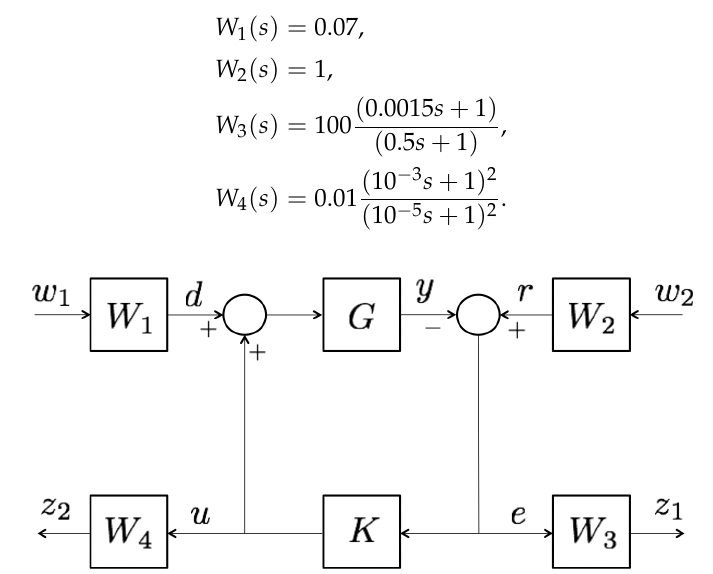
Figure 27. Interconnected system for the design of the thrust AMB rotor support